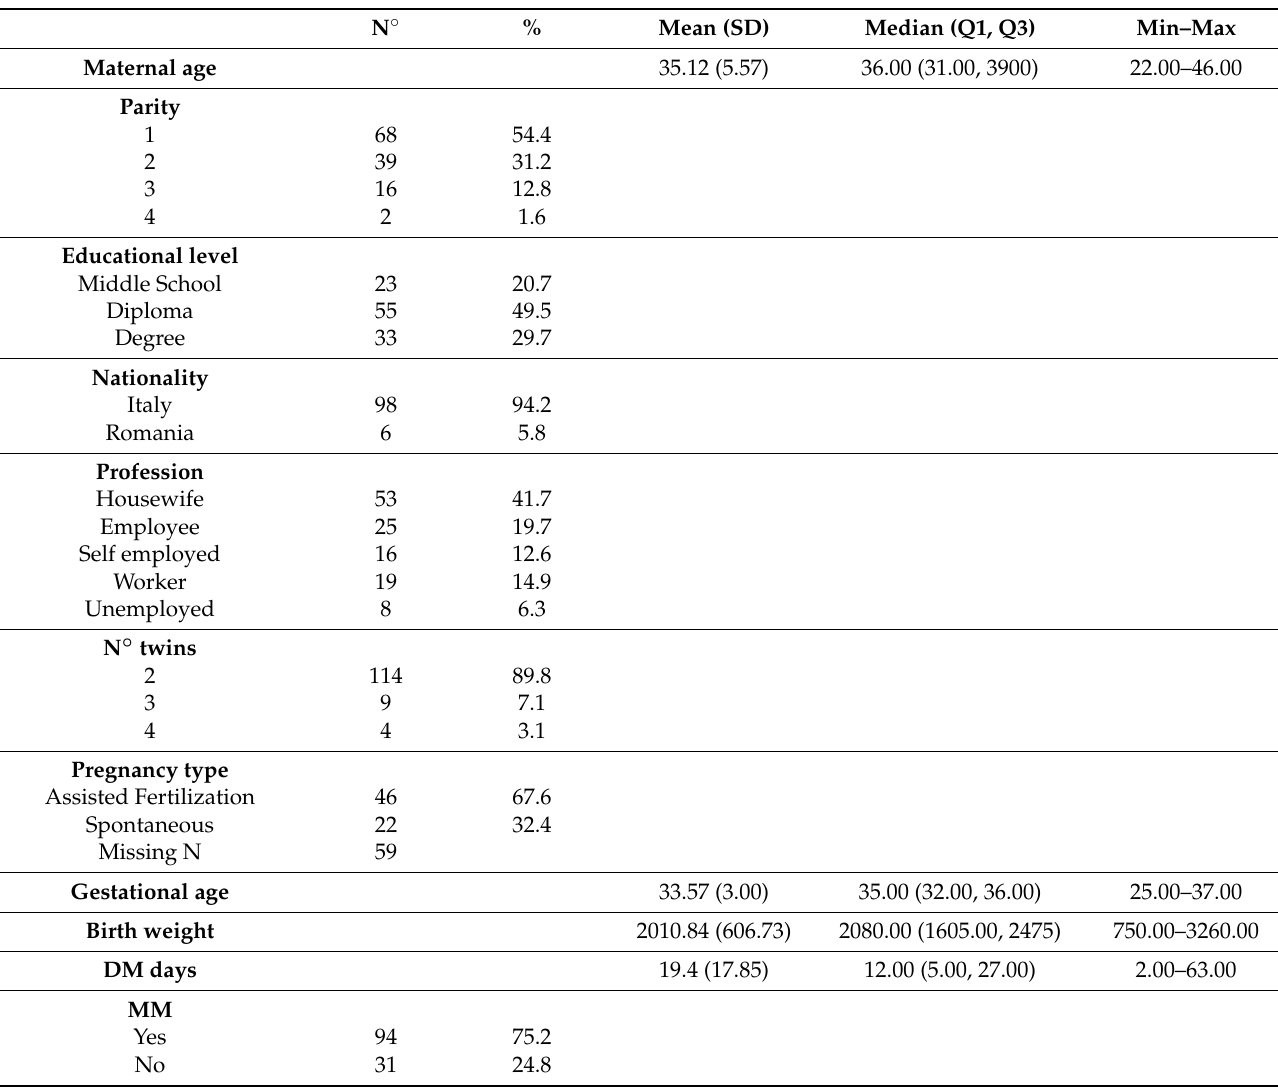
Table 3. Mean, median, and